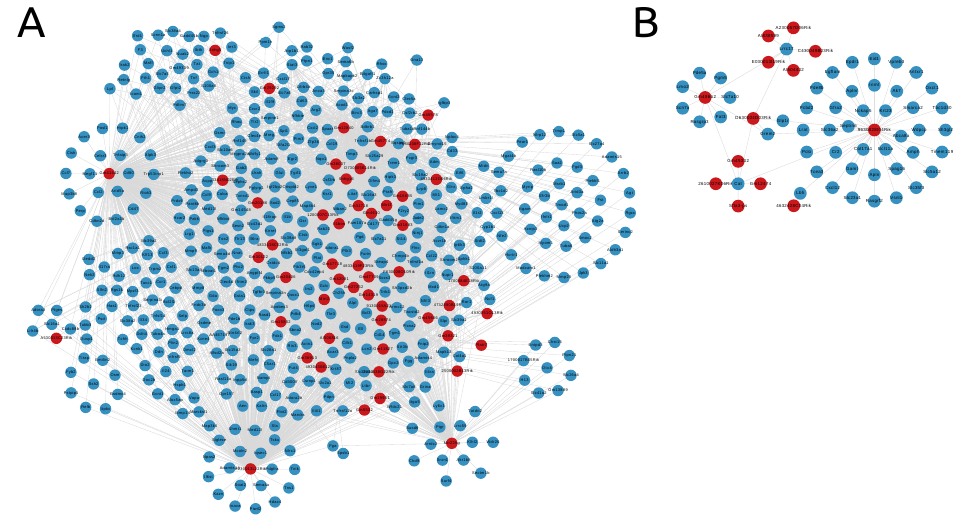
Figure 6. Subnetworks representing the selected protein-coding genes (in blue) and lncRNAs (in red). ( A ) Turquoise module. ( B ) Blue